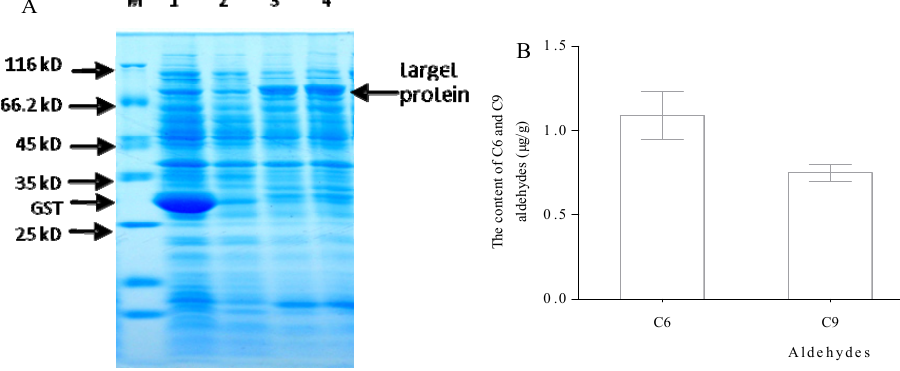
Figure 10. Expression of recombinant CsHPL protein and analysis of recombinant enzyme using GC-MS. ( A ) Expression of recombinant CsHPL protein. M : Protein Marker; 1 : blank vector induced with 0.2 mM IPTG; 2 : recombinant vector induced with 0.1 mM IPTG; 3 : recombinant vector induced with 0.2 mM IPTG; 4 : recombinant vector induced